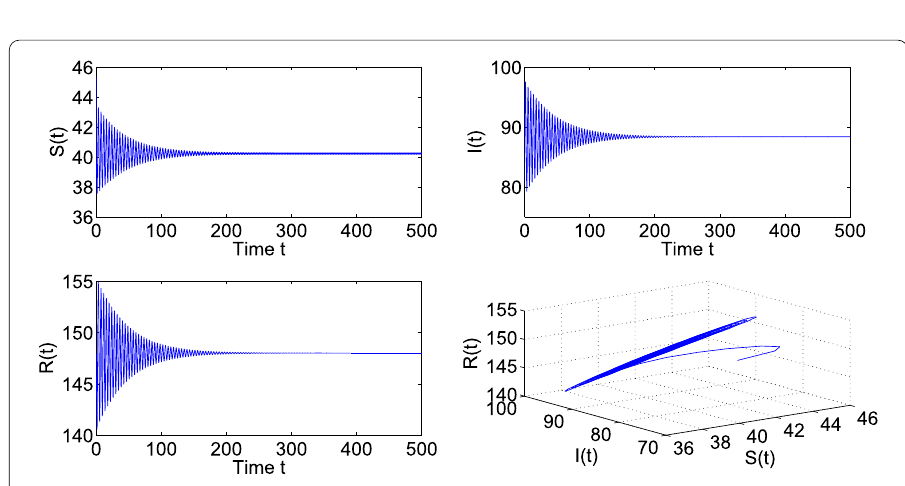
Figure 4 E ∗ is locally asymptotically stable when τ 2 = 1.326 < τ 20 = 1.4775